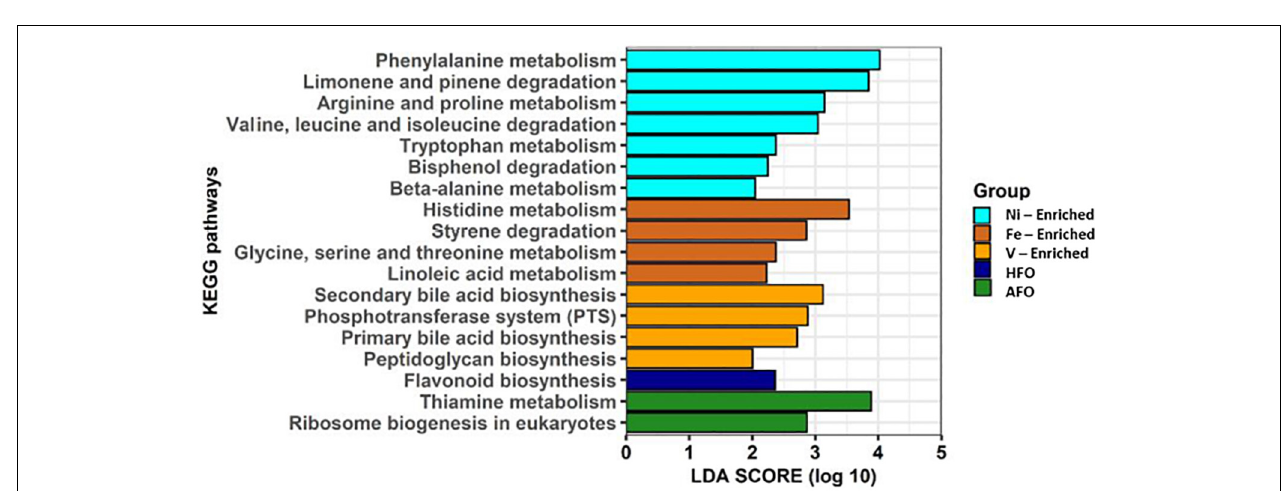
FIGURE 4 | Pearson correlation between 40 abundant genera in fish microbiome and five categories of petroleum hydrocarbons and three metals in diets. The color code at the right indicates type and degree of correlation. *Significant at an α -level of 0.05. **Significant at an α -level of 0.005. ***Significant at an α -level of 0.001. Abbreviations: CNT, control; ACO, Australian crude oil; HFO, heavy fuel oil; Al, aluminum; Fe, iron; Ni, nickel; PAH, total aromatic hydrocarbon; S, sulfur; Sn, tin; TBA, total bicyclic aromatics; TPA, total pentacyclic aromatics; TTetA, total tetracyclic aromatics; TTriA, total tricyclic aromatics; V, vanadium.